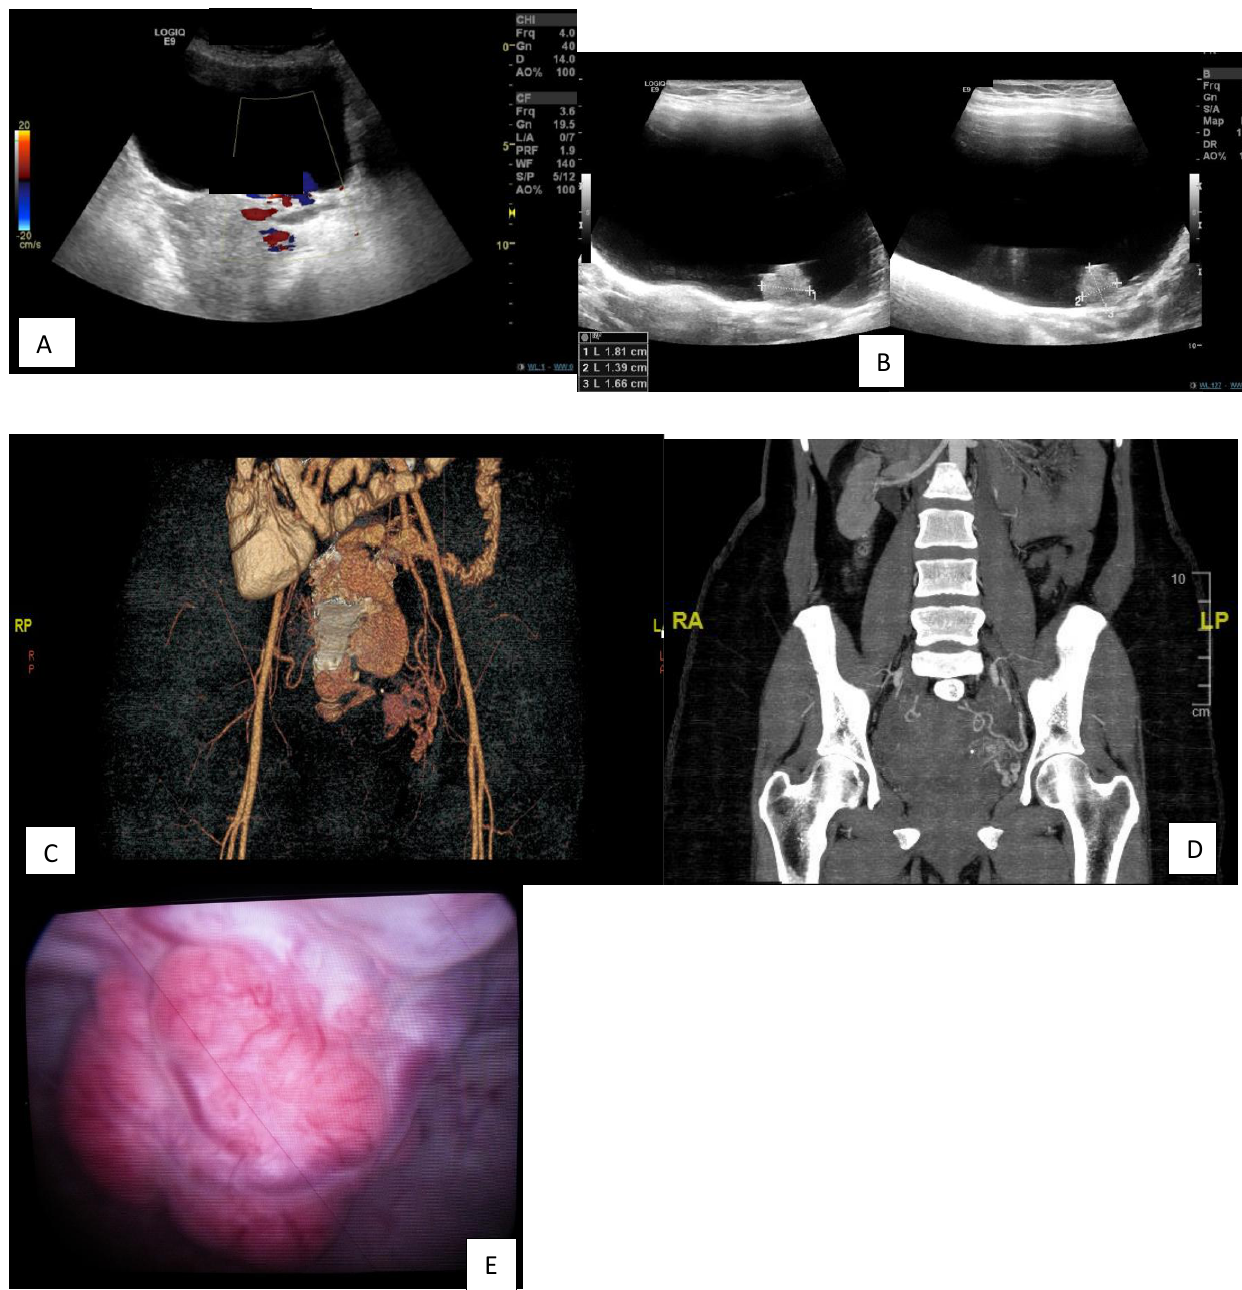
Figure 1. Lesion arising from the urinary bladder wall and diagnostic cystoscopy. ( A ): An ultrasound shows a Pepsi sign on the color Doppler. ( B ): an ultrasound grey scale shows a lesion from the urinary bladder wall. ( C , D ): Ct with Iv contrast and processed image of the CT shows a hyper-vascular lesion in the urinary bladder wall. ( E ): a large, pulsatile, submucosal mass and a wide-based stalk in Diagnostic